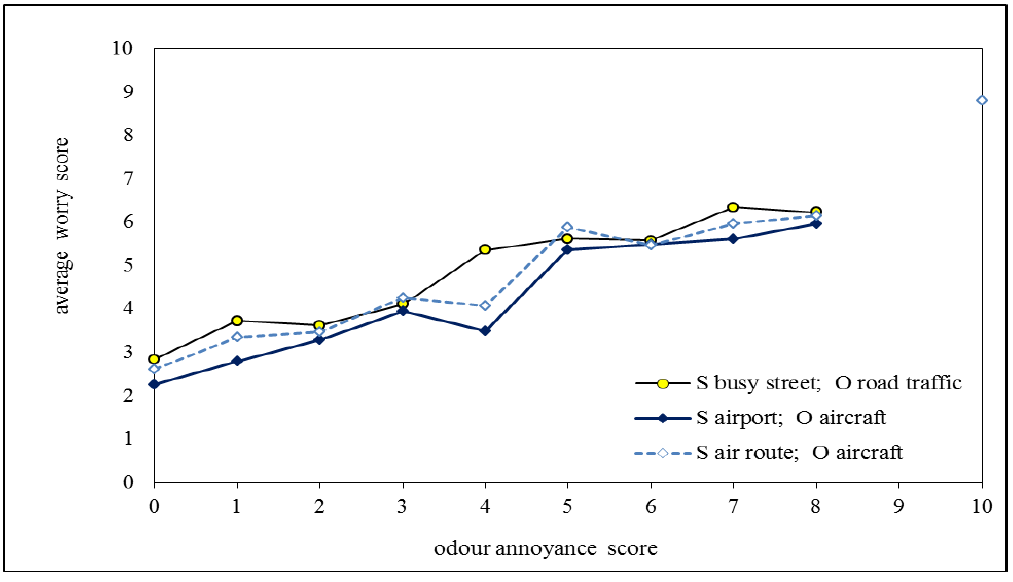
Figure 5. Relation between average worry score and odour annoyance score for respondents living in one of three situations (close to aircraft route, close to airport and on busy street) and who report to smell the odour source. Legend: S = situation (living on/close to…); O = odour